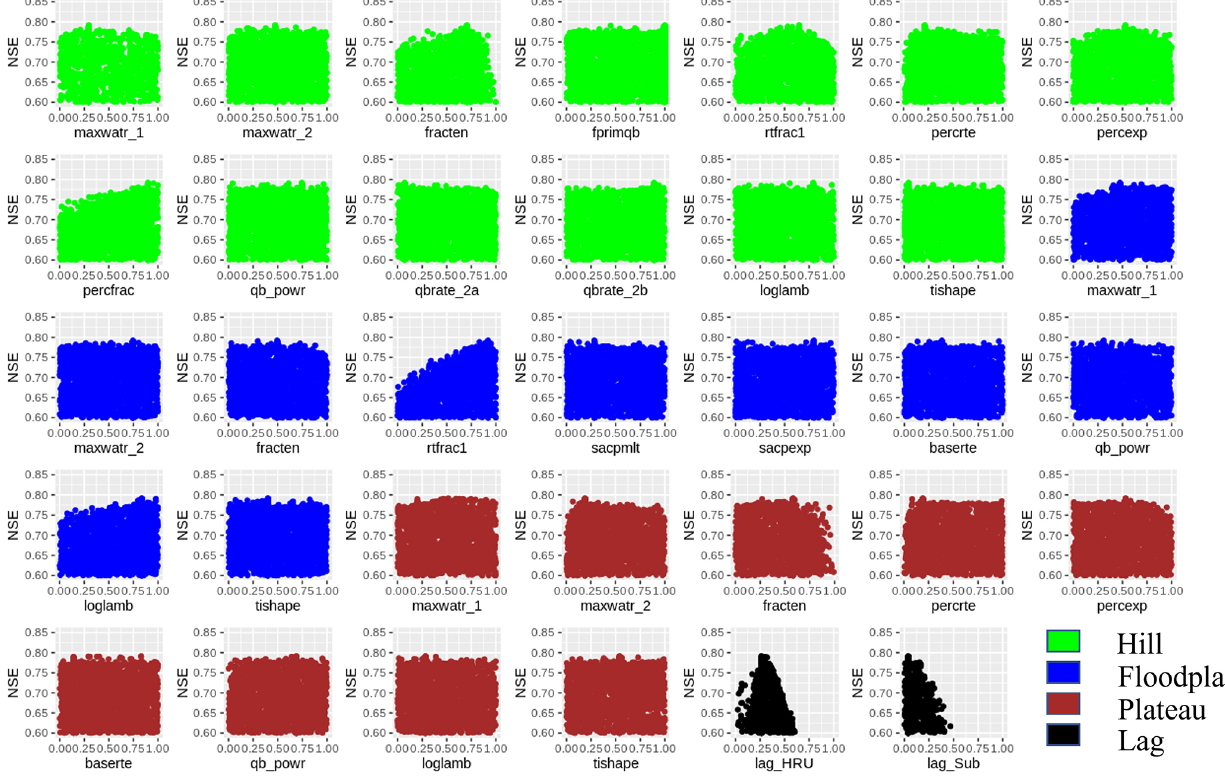
Figure A2. Sensitivity scatterplots of